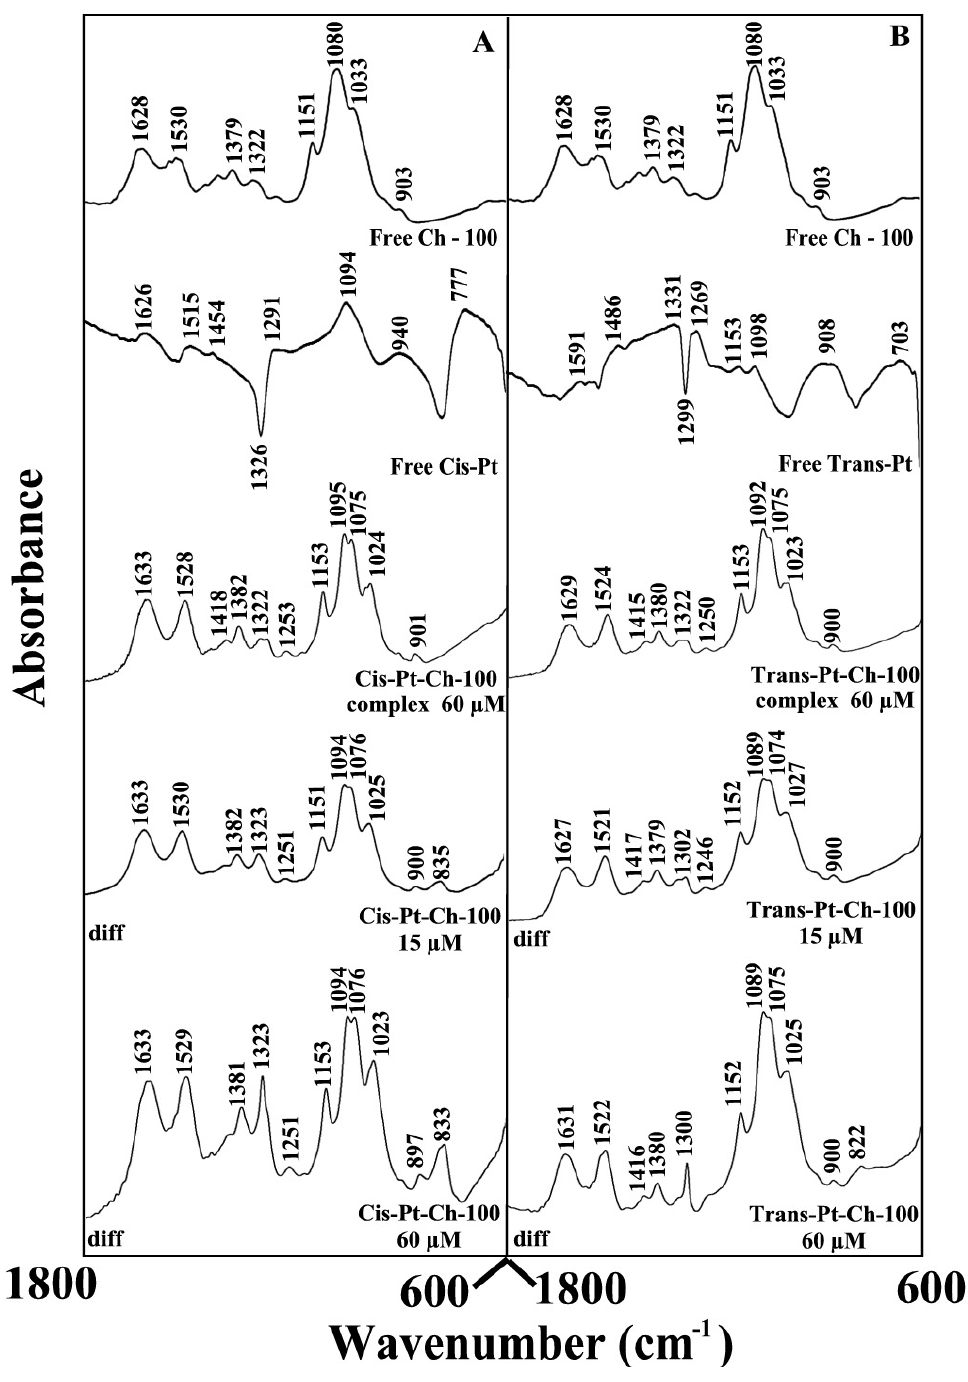
Figure 6. FTIR spectra in the region of 1800–600 cm − 1 of hydrated films (pH 5–6) for chitosan–100 KD with cis–Pt ( A ) and trans–Pt ( B ) with chitosan (60 µ M) and its Pt conjugates with difference spectra (diff.) (bottom two curves) obtained at different drug concentrations (indicated on the figure).